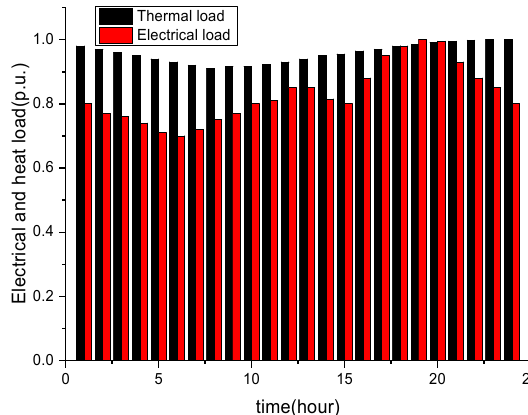
Table 3. Assumed line data.